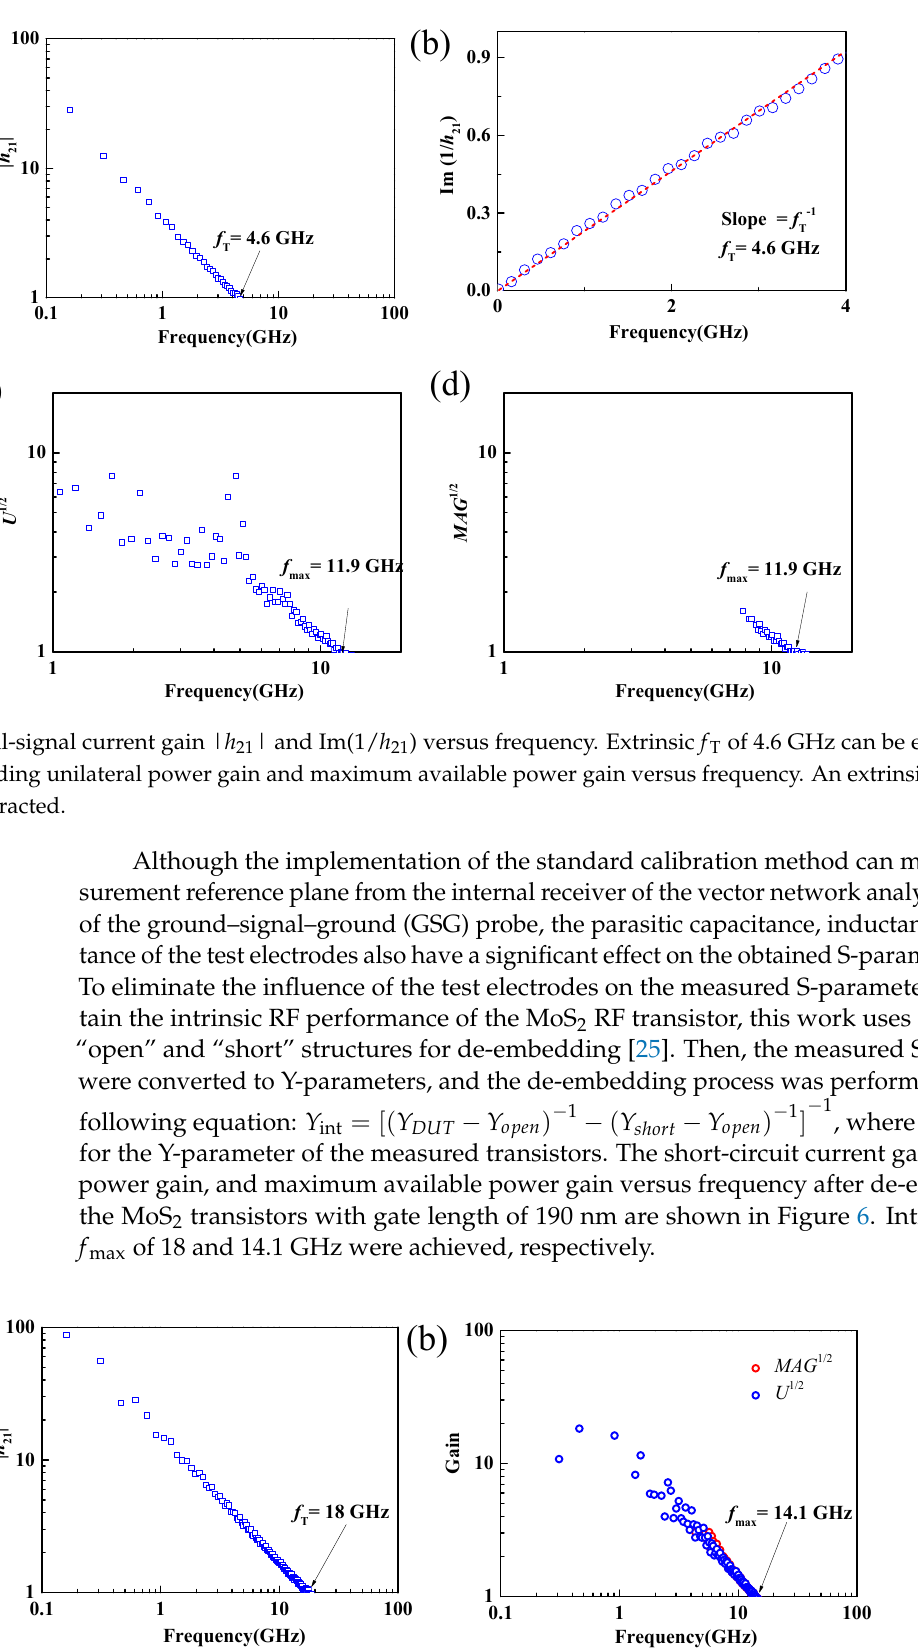
Figure 6. ( a ) Small-signal current gain | h 21 | versus frequency, ( b ) unilateral power gain and maximum available power gain versus frequency. Intrinsic f T and f max of 18 and 14.1 GHz could be extracted.